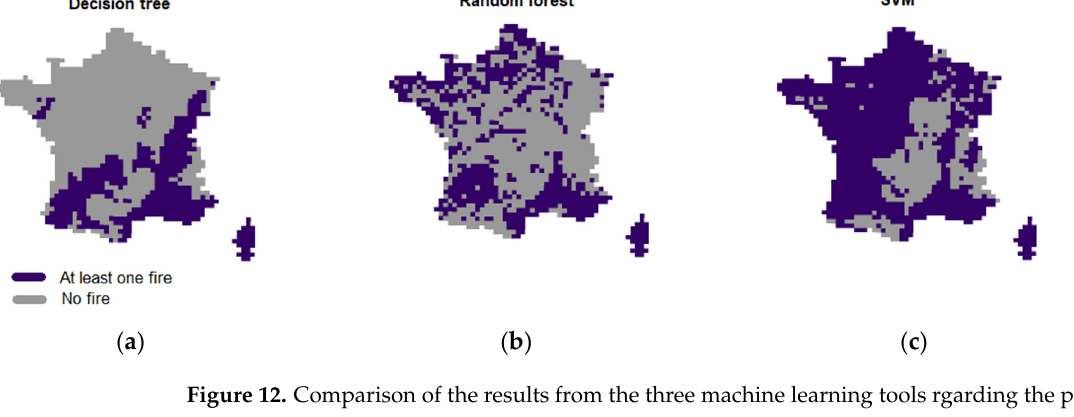
Figure 12. Comparison of the results from the three machine learning tools rgarding the probability of at least one fire within the 2 km DFCI mesh during summer 2050 RCP 4.5. ( a ) The decision tree projection is the more moderated model; we observed the exposure of Landes, Rhône valley and Vosges. ( b ) The random forest’s projection highlights the Mediterranean and Corse areas’ exposure, with an increasing exposure of the Rhône valley, Landes, Bretagne, Nord-Pas-de-Calais and Pays-de-Loire; this model seems to be the more coherent one. ( c ) SVM’s projection is the more pessimistic model, generating fire events in the large majority of the territory; the results are more related to the RCP 8.5 pessimistic scenario.